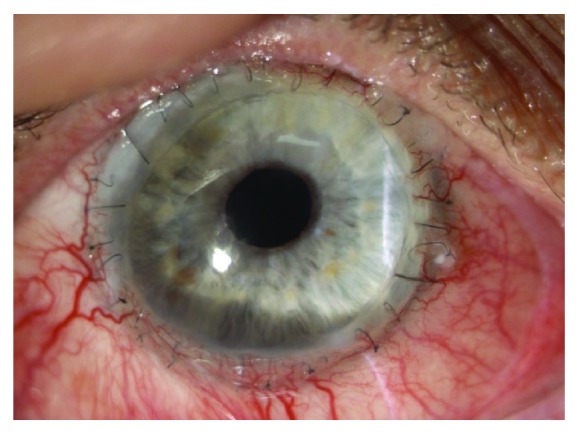
Transparent graft.